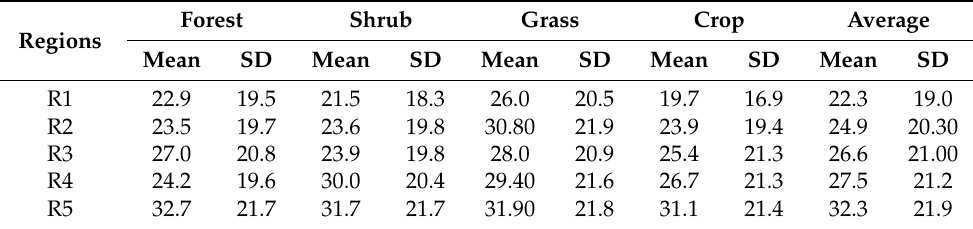
Table 4. Impacts of climate change ( I climate ) on terrestrial vegetation growth in China. The unit is %. Forest Shrub Grass Crop Regions